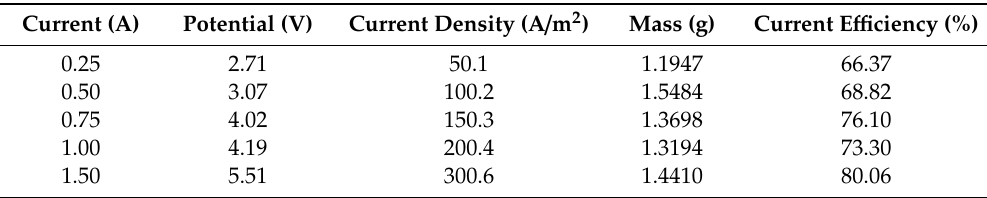
Table 3. Results of the electrodeposition of cobalt.